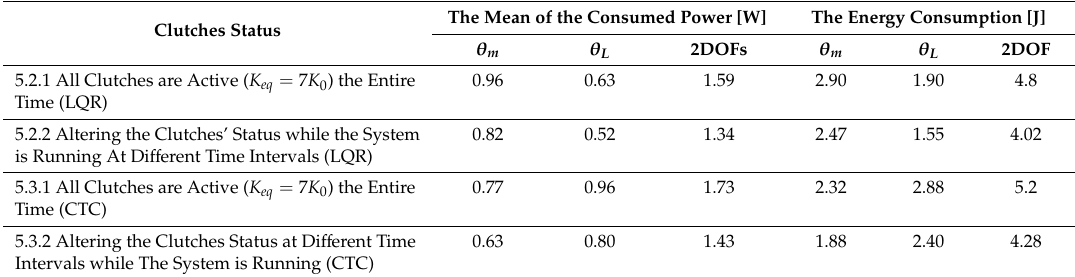
Table 4. The quantitative values of power and energy consumption for each case using both types of